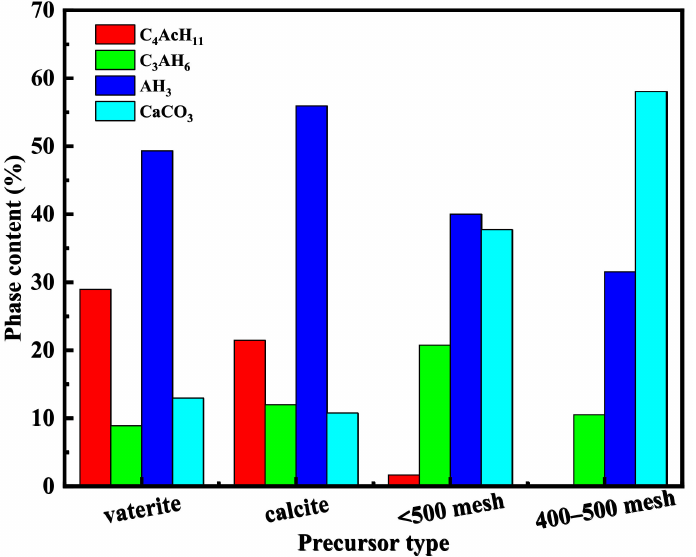
Figure 2. Phase content of composite